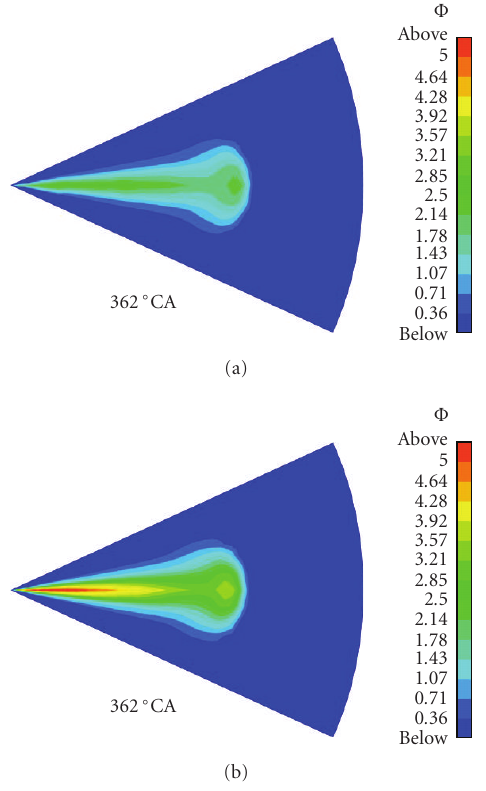
Figure 15: Equivalence ratio in the emulsion spray (upper) and diesel spray (lower), cutplane A.